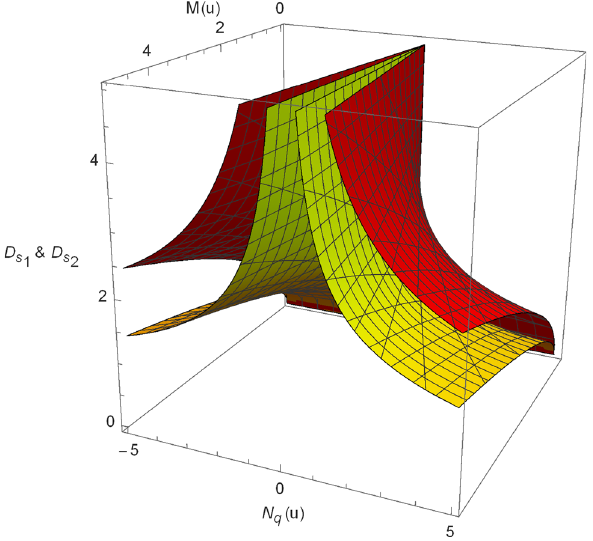
Fig. 11 The variation of D s (yellow plot) and D s (red plot) versus 1 2 typical values of the M ( u ) and N q ( u ) parameters for the quintessence background Fig. 12 The variation of R versus typicalvalues of the L and N param- eters in (47) for the quintessence background. We have set M = 1 without loss of